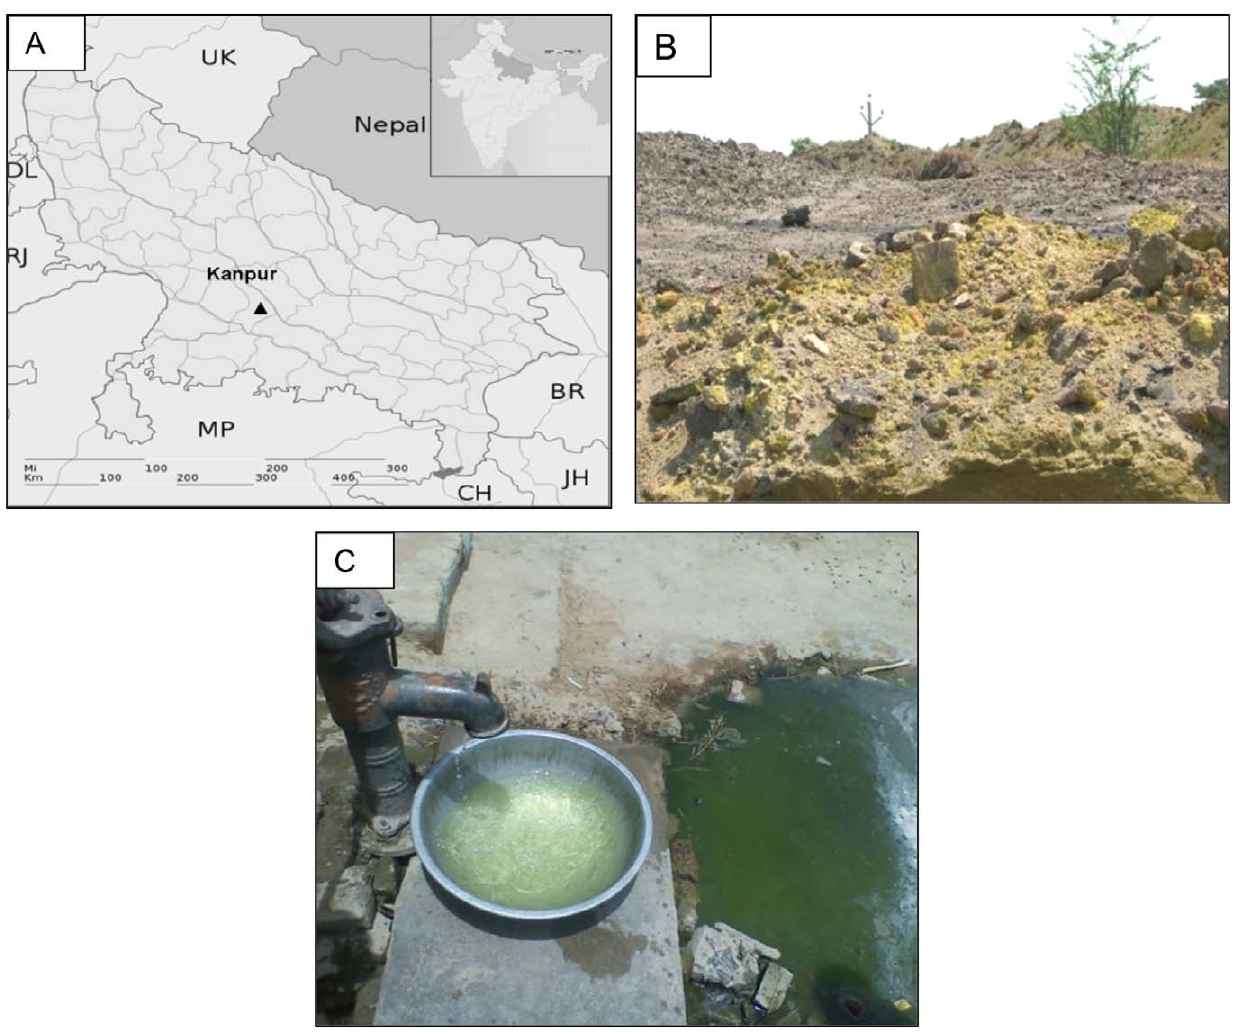
Figure 1. Selected characteristics of the study location. (A) Map showing city of Kanpur- Figure in inset is map of India showing Uttar Pradesh state (U.P.) (dark filled). Surrounding states: UK-Uttarakhand, HR- Haryana, DL- Delhi, RJ- Rajasthan, MP- Madhya Pradesh, CH- Chattisgarh, JR- Jharkhand, BR- Bihar and far-east country Nepal; (B) Photograph of a chrome sludge dumping site at Kanpur (C) Photograph showing yellow colored contaminated water from a handpump.